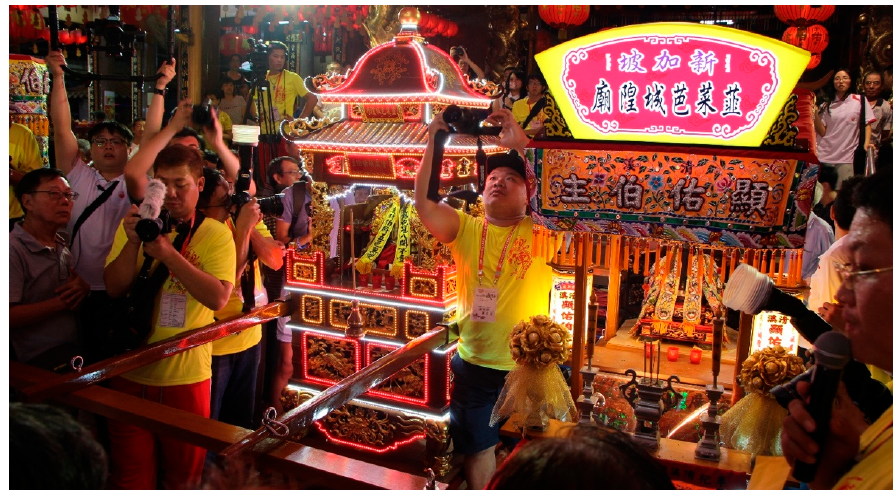
Figure 7. Cheng Huang Ye and his Redistributed Effigies and Palanquins. (Source: Alvin Eng Hui Lim).